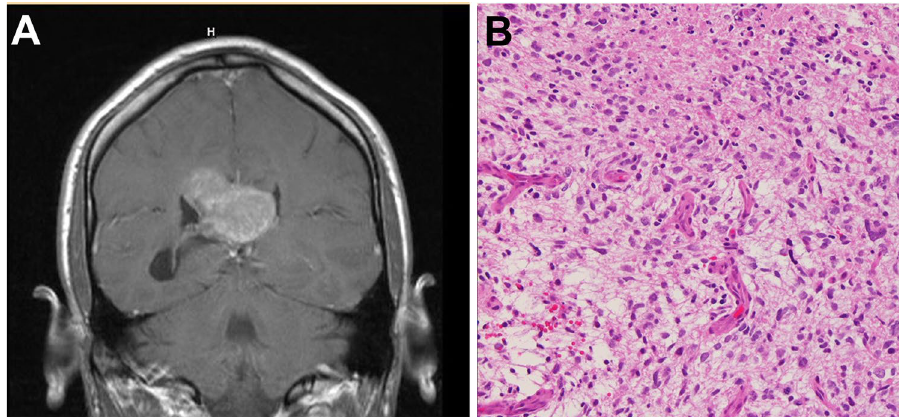
Figure 2. Magnetic resonance imaging and histological features of a representative BRAF mutated tumor. Patients with BRAF mutant GBMs were typically found adjacent to the ventricular system ( A ). BRAF mutated tumors did not show distinctive histomorphology compared to classical GBM ( B ).